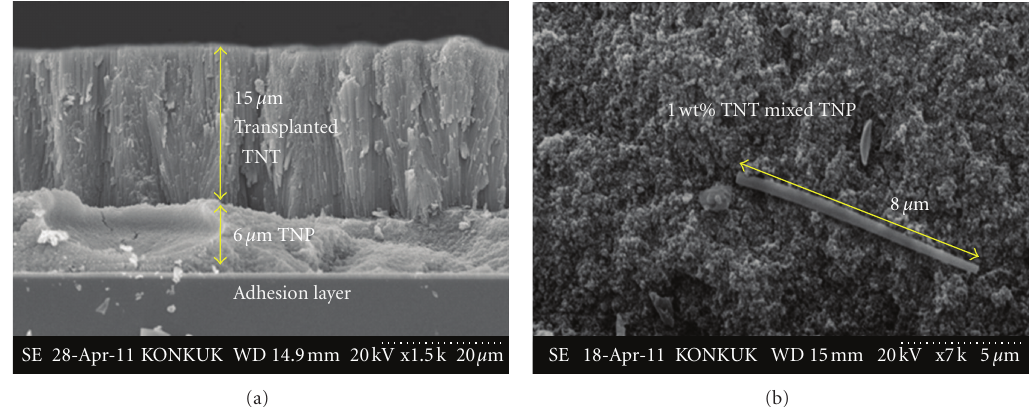
Figure 4: Scanning electron microscopic images (SEM): (a) cross-sectional image of transplanted TNT onto TNP, and (b) top view of 1 wt% TNT-mixed TNP photoelectrode.